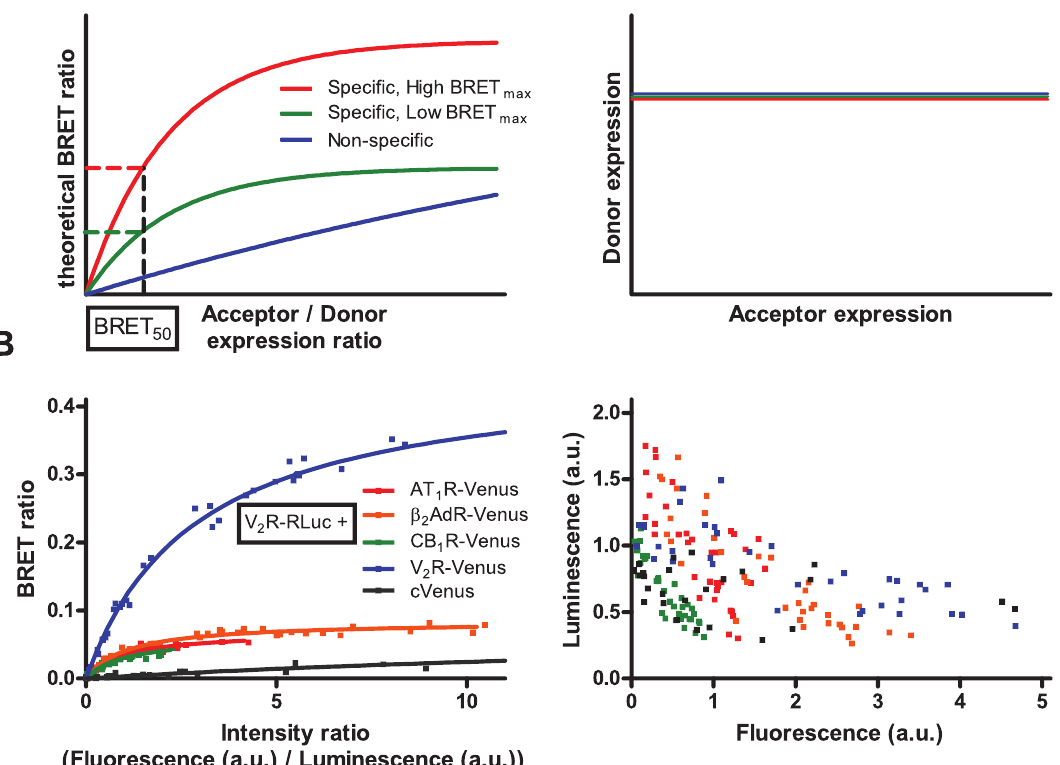
Figure 1. Classical qBRET experiments. (A) Schematic representation of qBRET experiments (based on [12]): In qBRET experiments, constant amount of energy donor labeled receptor is coexpressed with increasing amount of acceptor labeled receptor. BRET ratio is plotted as a function of acceptor/donor expression ratio (left panel). Theoretically specific interactions result in a saturation curve (red and green), while non-specific interaction shows linear relationship (blue). The absolute value of BRET ratio is not indicative of the dimerization state of the receptors, therefore BRET 50 value (acceptor/donor ratio at half-maximal BRET ratio) is used to determine the affinity of receptors to form dimers (which is the same for red and green curve, indicating the same likelihood of dimerization despite the different BRET max values). To correctly interpret qBRET curves, donor labeled receptor expression has to be maintained constant with increasing acceptor expression (right panel). (B) HEK293 cells were transiently transfected with a constant amount V 2 R-RLuc (donor) coding plasmid and with increasing amounts of either AT 1 R-Venus, b 2 AdR-Venus, CB 1 R-Venus, V 2 R-Venus or cytoplasmic Venus (acceptor) coding plasmid. Various amounts of empty pcDNA3.1 plasmid was added to maintain constant total transfected plasmid amount. Total luminescence and Venus fluorescence were measured at the beginning of each experiment, and intensity ratio was calculated as fluorescence/total luminescence. Intensity ratio shows not the absolute acceptor/donor expression ratio (see Methods for further details) but is proportional with it. BRET ratio was calculated as Emission 530 /Emission 485 , and was plotted as a function of intensity ratio (left panel). Measured total luminescence was plotted as a function of measured fluorescence for the investigated donor - acceptor pairs (right panel). Curves were fitted using non-linear regression equation assuming a single binding site (GraphPad Prism). n=3. doi:10.1371/journal.pone.0109503.g001 100 nM rapamycin or vehicle DMSO was added to the cell Figures, statistical analysis medium 30 minutes prior the measurements. Figures, curve fitting and statistical analysis were performed in GraphPad Prism. All measurements were repeated from n = 3 to 8 (different transfections), and pooled data were plotted. For GPCR